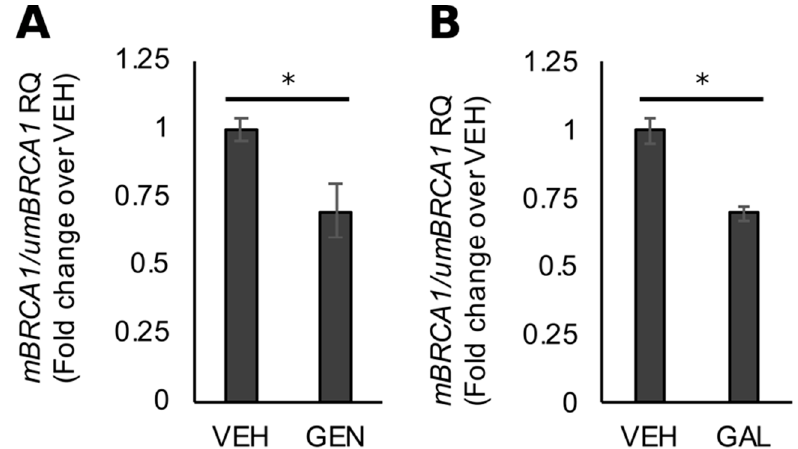
Figure 4. Rescue of BRCA1 expression is linked to CpG demethylation in TNBC cells. The average ratio of mBRCA1 / umBRCA1 in HCC38 cells treated for 96 h with ( A ) GEN or ( B ) GAL. Bars represent sample means ± SEM from ≥ 3 biological replicates from individual experiments. Asterisks denote significance (*, p<0.05).